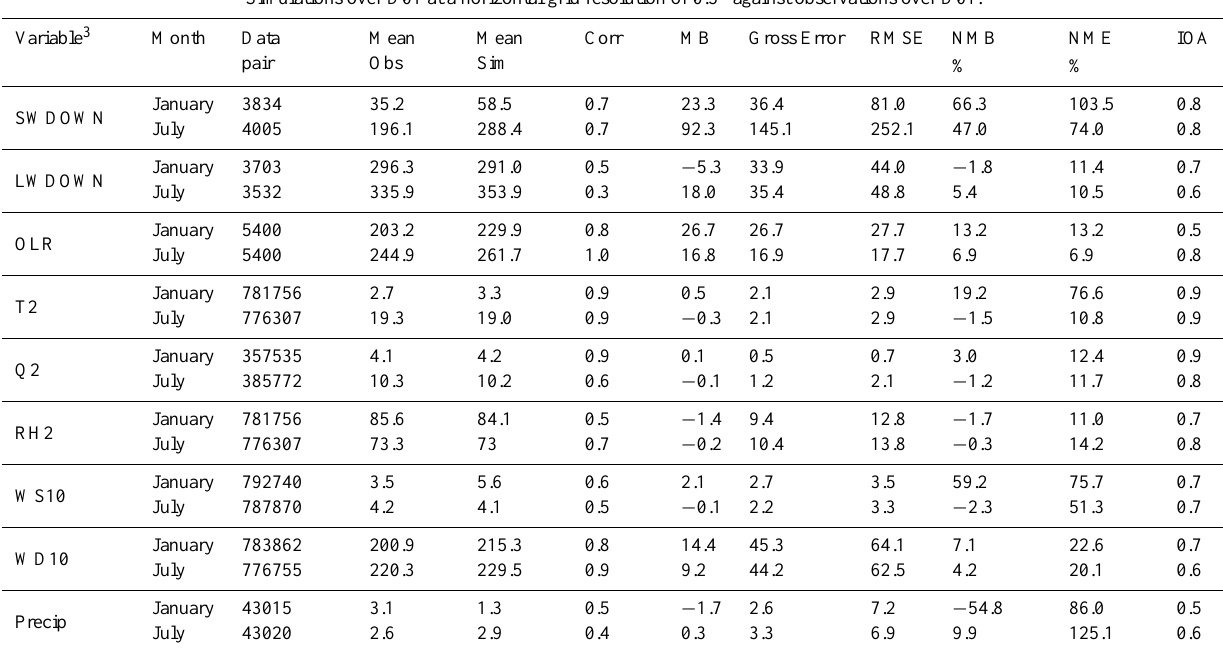
Table 4a. Comparison of performance statistics of WRF in January and July 2001 1 , 2 . Simulations over D01 at a horizontal grid resolution of 0.5 ◦ against observations over D01.